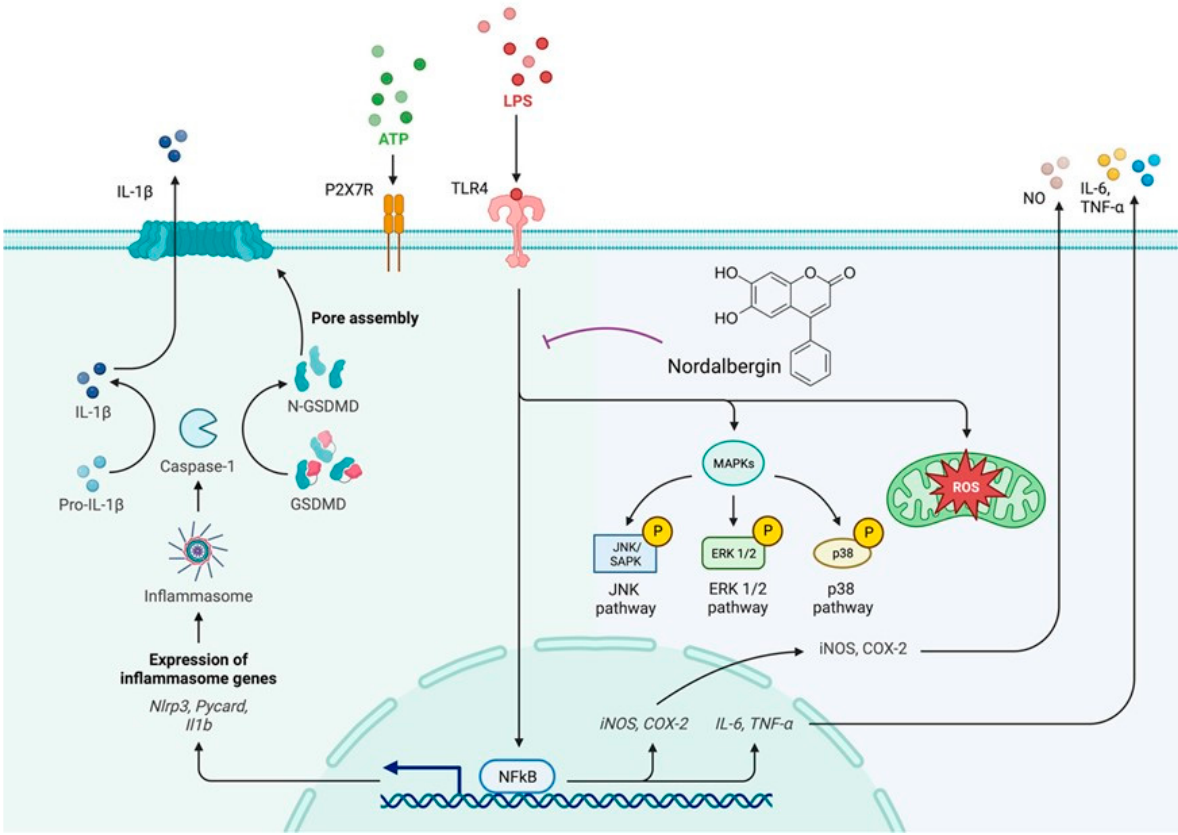
Figure 6. Nordalbergin exhibits anti-inflammatory and anti-oxidant properties in LPS-stimulated microglial BV2 cells. Our results demonstrated that nordalbergin decreases the secretion of NO, TNF- α , IL-1 β and IL-6; represses the expression of iNOS and COX-2; suppresses the activation of MAPKs signaling pathways; a tt enuates the activation of NLRP3 in fl ammasome; and reduces the production of both intracellular and mitochondrial ROS by LPS-stimulated microglial BV2 cells. These results suggest that nordalbergin exerts anti-neuroin fl ammatory e ff ects by a tt enuating MAPK signaling pathways, NLRP3 in fl ammasome activation and ROS production in LPS-stimulated BV2 microglia. The purple broken line means inhibition.